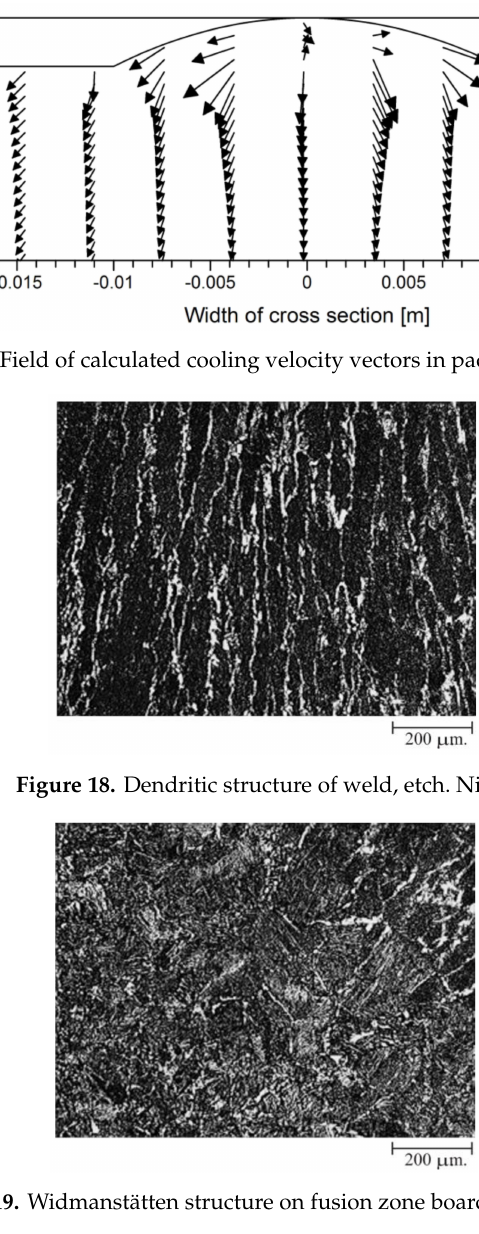
Figure 19. Widmanstätten structure on fusion zone board, etch. Nital.